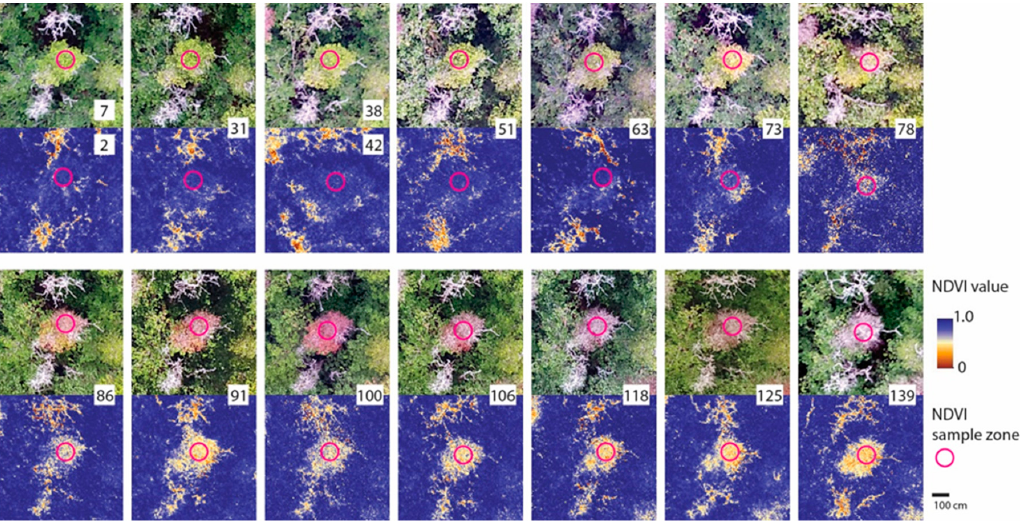
Figure 11. Time series of RGB (top) and NDVI (bottom) sUAS paired images for Tree 214 in the field inoculation trial. The numbers indicate the number of days since inoculation. Of the two VIs derived from the field inoculation trial sUAS imagery, NDVI was able to consistently detect stress onset prior to ExG-ExR, but only by a moderate amount (4.5 days earlier on average, maximum early detection of 18